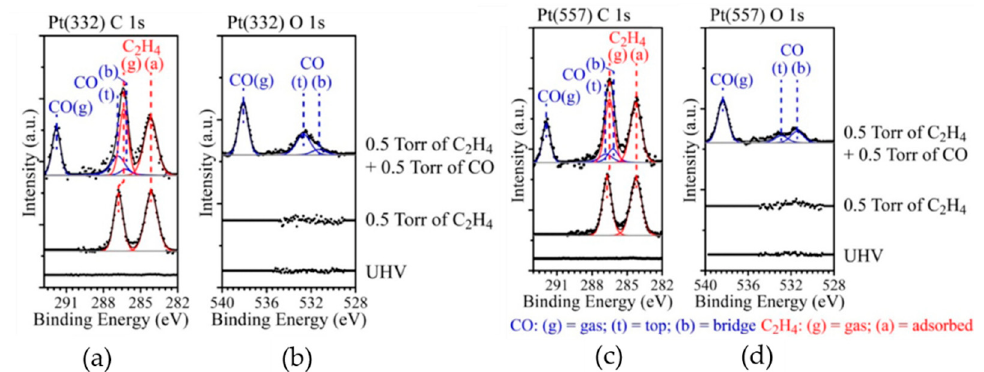
Figure 9. ( a , c ) C 1s spectra of Pt(332) and Pt(557) after adding C 2 H 4 and subsequently CO, and Figure 9. ( a,c ) C 1s spectra of Pt (332) and Pt (557) after adding C 2 H 4 and subsequently CO, and ( b,d ) ( b , d ) corresponding O 1s spectra of Pt(332) and Pt(557). From bottom to top: in UHV, under 0.5 Torr of corresponding O 1s spectra of Pt (332) and Pt (557). From bottom to top: in UHV, under 0.5 Torr of C 2 H 4 , under 0.5 Torr of C 2 H 4 + 0.5 Torr of C 2 H 4 , under 0.5 Torr of C 2 H 4 + 0.5 Torr of CO.